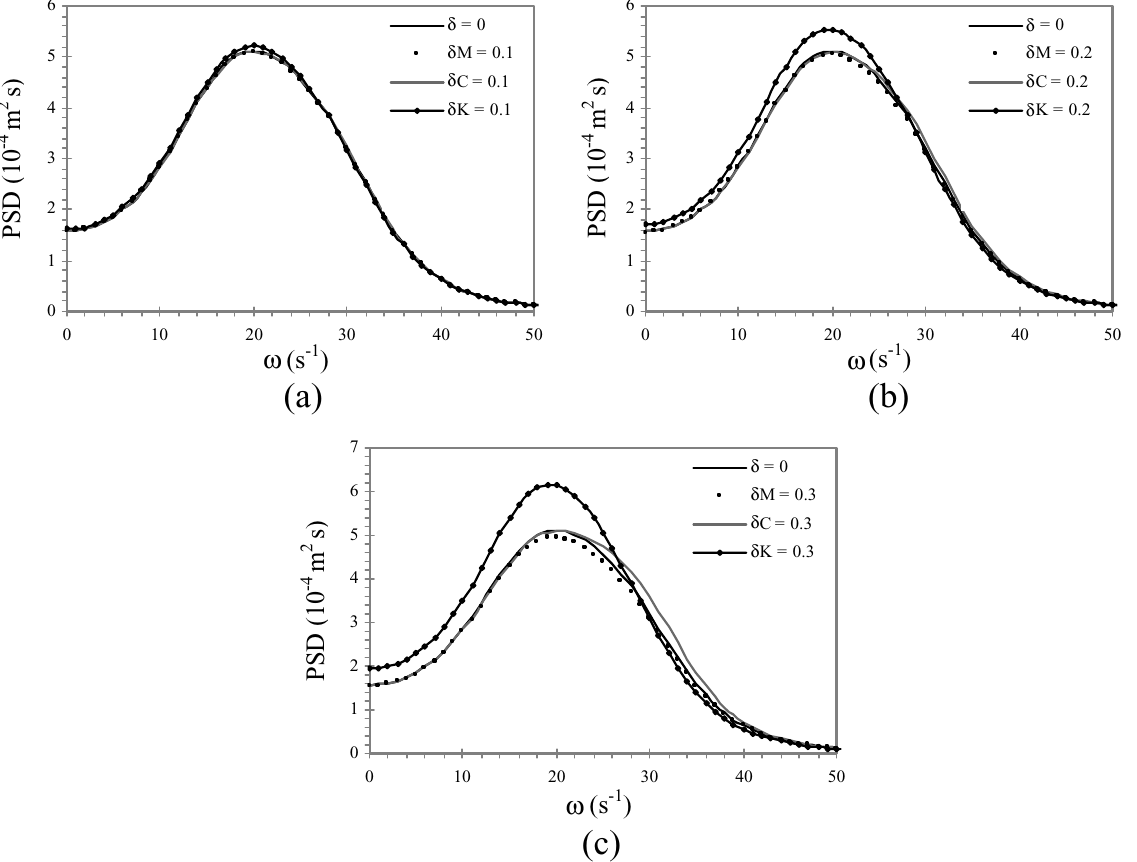
Fig. 4. PSD curves of Y 20 for independently varying stochastic matrices with dispersion parameters: (a) 0.1; (b) 0.2; and (c) 0.3. sponding dispersion parameters. 5000 samples were used for all Monte-Carlo simulations. Figure 4(a) shows the variation of the random response PSD sensitivities for this stochastic dynamic system with the dispersion parameter combinations ( δ M = 0.1, δ C = δ K = 0), ( δ C = 0.1, δ M = δ K = 0) and ( δ K = 0.1, δ M = δ C = 0). It can be